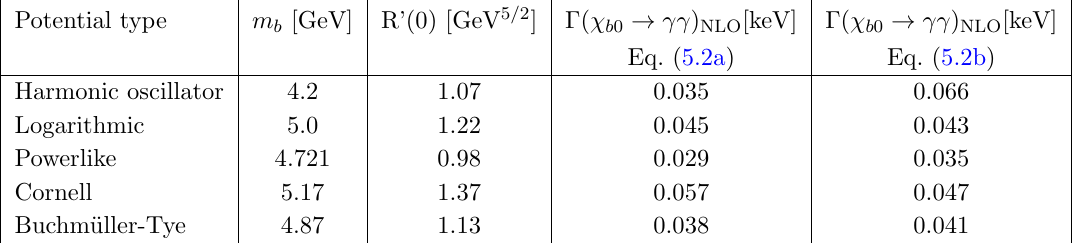
Table 7 . (cid:0)( (cid:31) b 0 ! (cid:13)(cid:13) ) NLO according to eqs. (5.1), (5.2) with respect of quark mass for distinguished potential. R 0 (0) is obtained from eq. (3.18) and compared to R 0 (0) extracted from experiment as explained in the